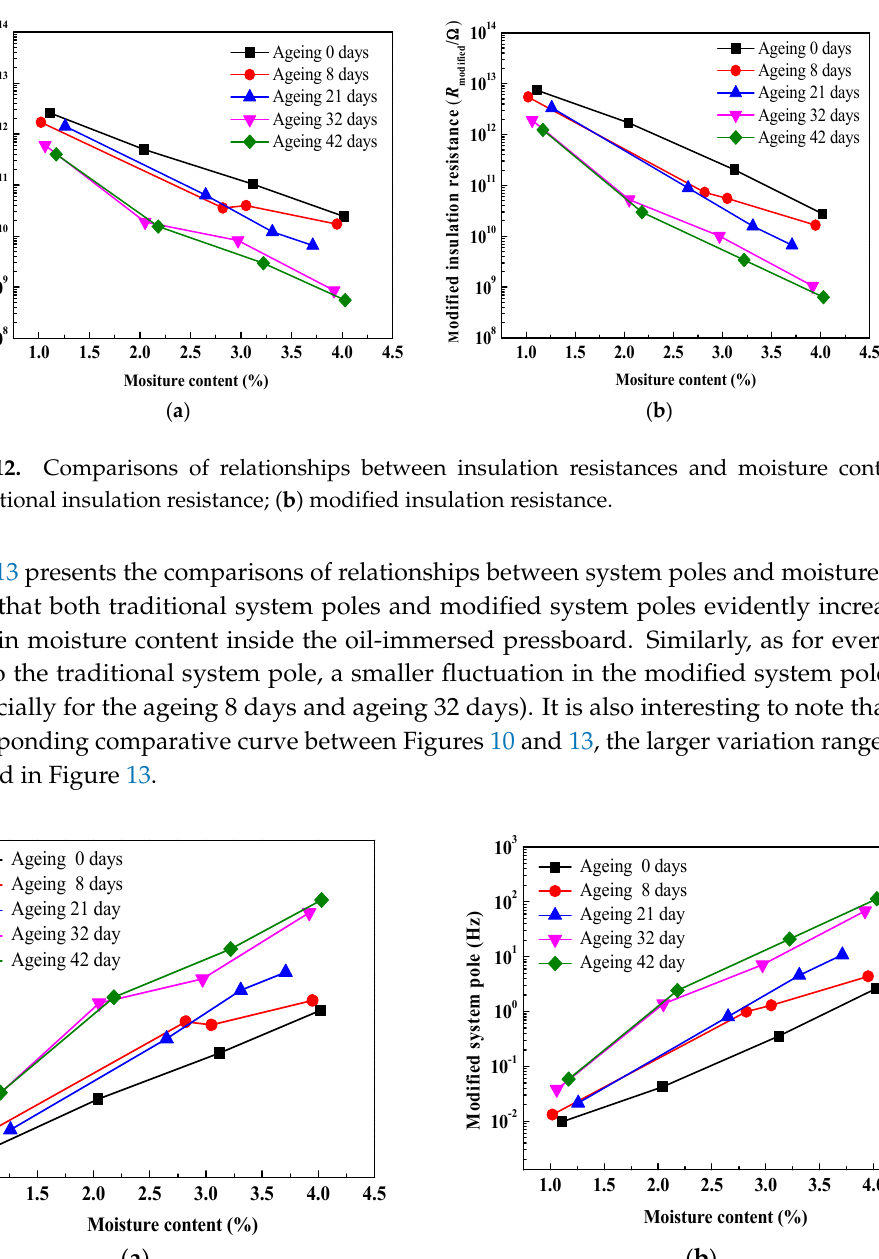
Table 2. Fitting equations between the modified system poles and DP values.